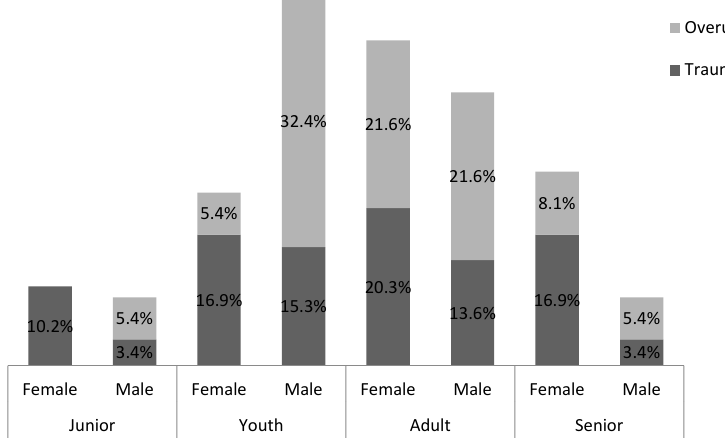
Figure 1. Percentage of traumatic and overuse injuries by gender and age-class.